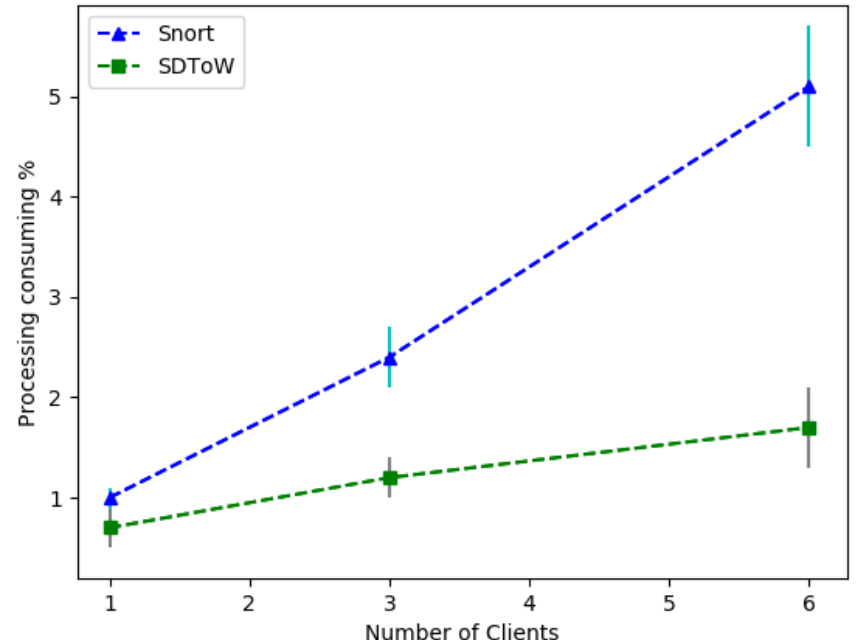
Figure 11. Processing consumption comparison for Snort and SDToW.